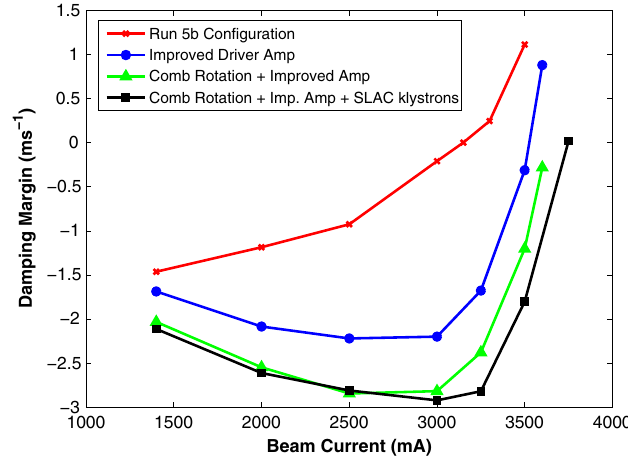
FIG. 11. (Color) Estimated damping margins at 4.05 MV.